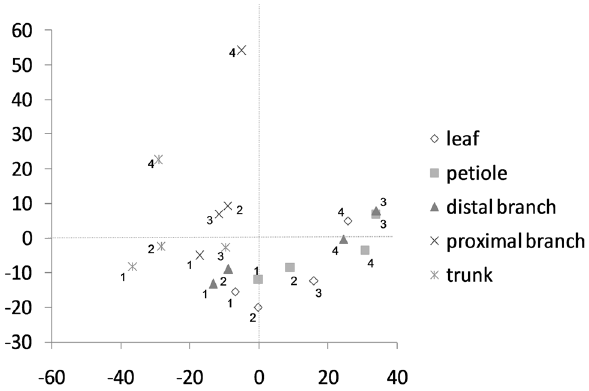
Figure 1. Canonical discriminant analysis on the chemicals from full-sibling (1, 2) and half-sibling (3, 4) avocado trees. Locations sampled included leaf, petiole, distal branch section (0.5 cm diam), proximal branch section (3.8 cm diam) and trunk (n=3 samples per tree per location).